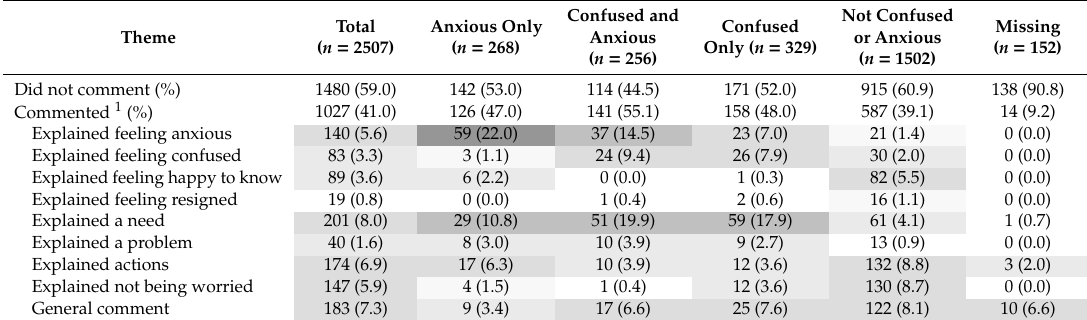
Table 3. Thematic reasons for psychological reaction for all notified women ( n = 2507) by four groups defined by quantitative likert responses: Anxious only ( n = 268), Confused and anxious ( n = 256), Confused only ( n = 329), and Not confused or anxious ( n = 1502). Darker shaded boxes represents most common